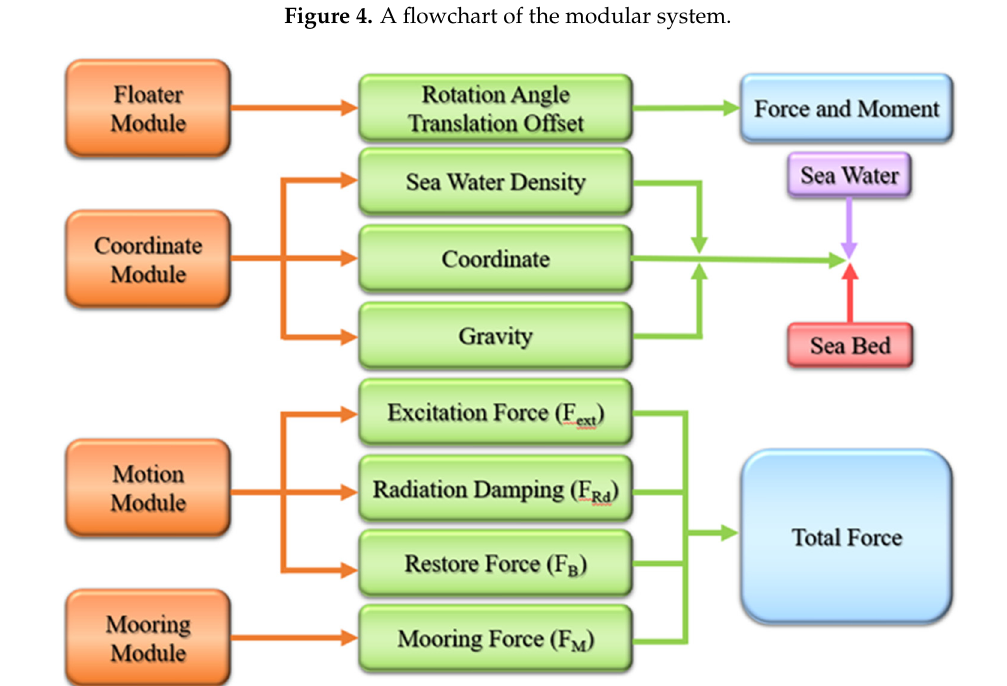
Figure 5. The functions in the modular system.